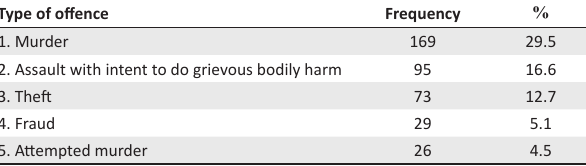
TABLE 2: Five most prevalent index offences.